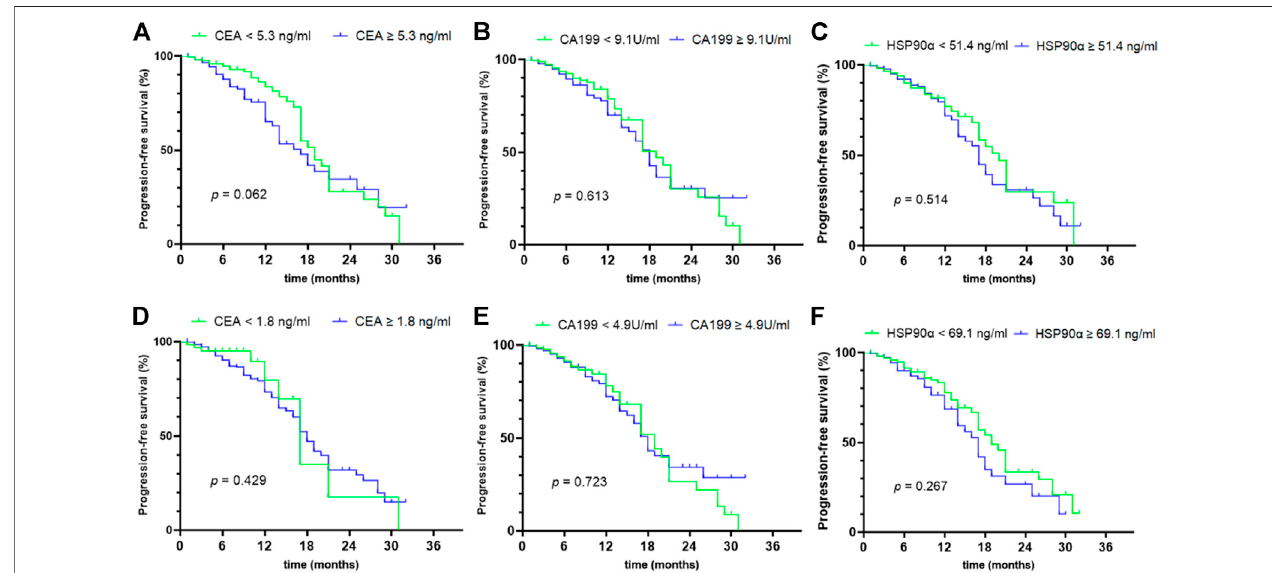
FIGURE5| prognosticvalueofinitialconcentrationsofCEA,CA199andHSP90 α incolorectalcancer. (A – C) TheprognosticvaluesofinitialconcentrationsofCEA, CA199 and HSP90 α were analyzed by grouping based on median value; (D – F) The prognostic values of initial concentrations of CEA, CA199 and HSP90 α were analyzed by grouping based on the cut-off value of ROC analysis in Figure 3A .